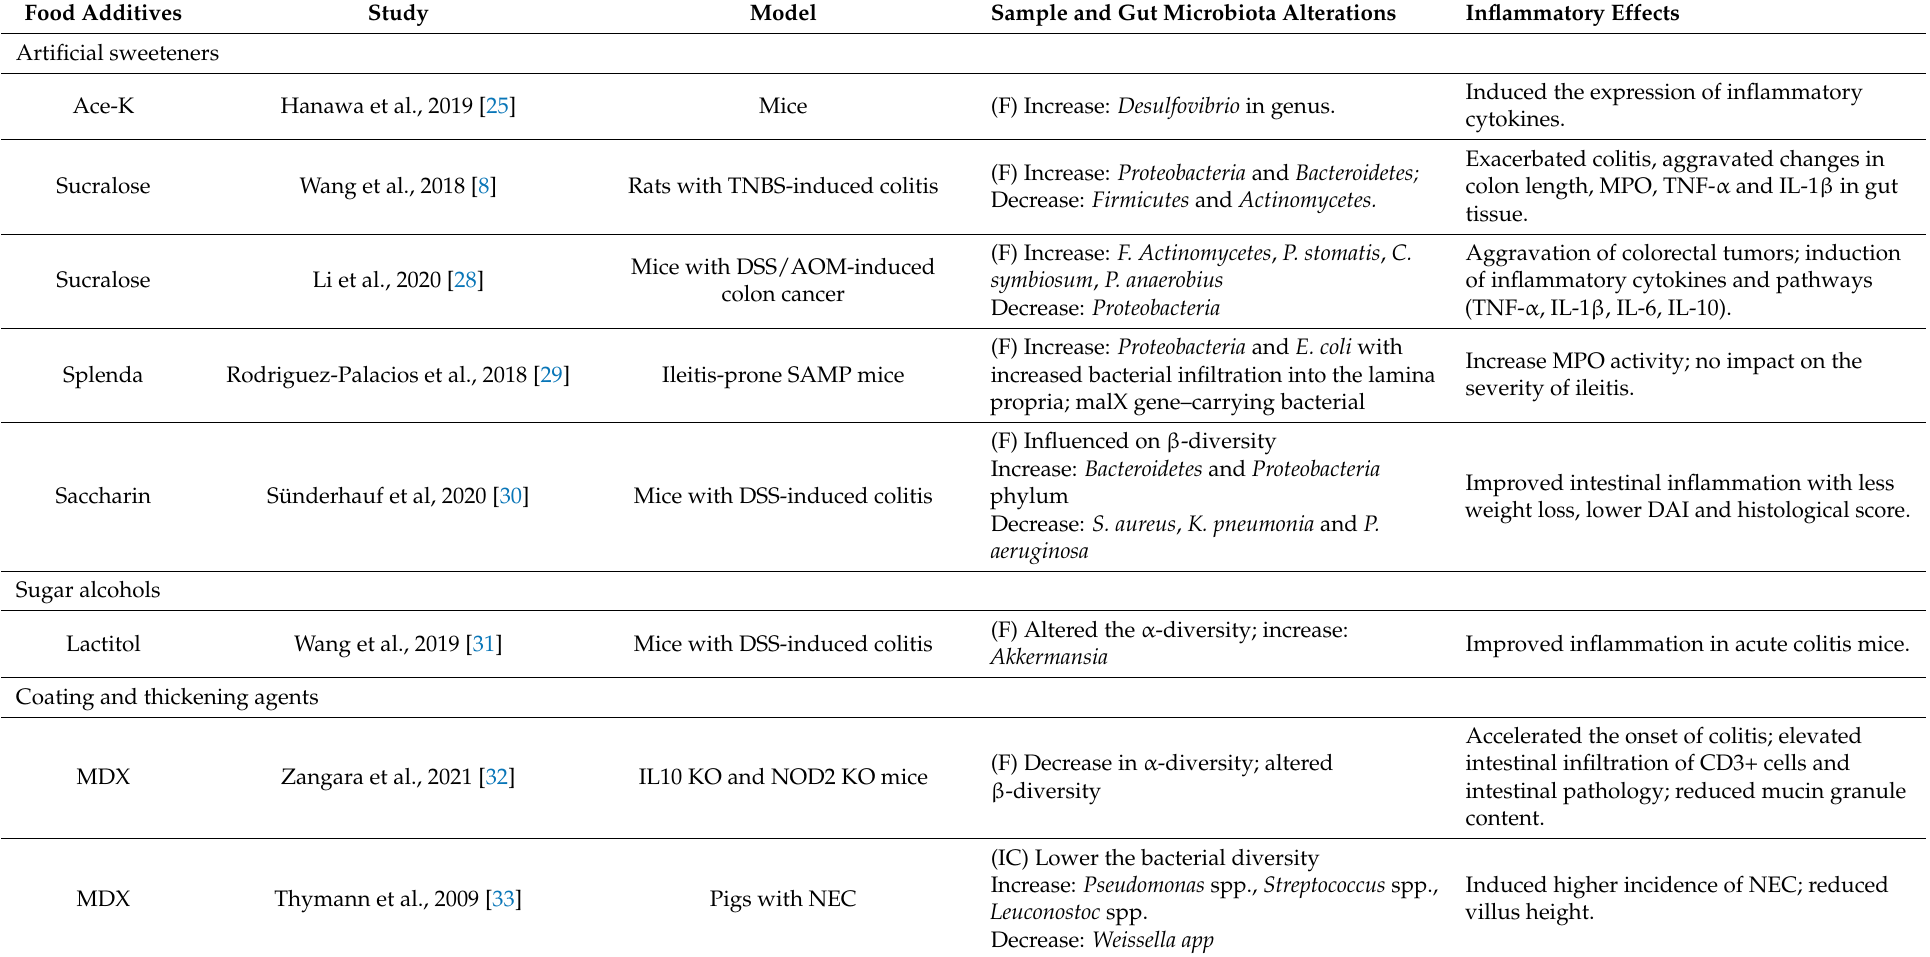
Table 1. The interactions among food additives, gut microbiota and inflammatory bowel